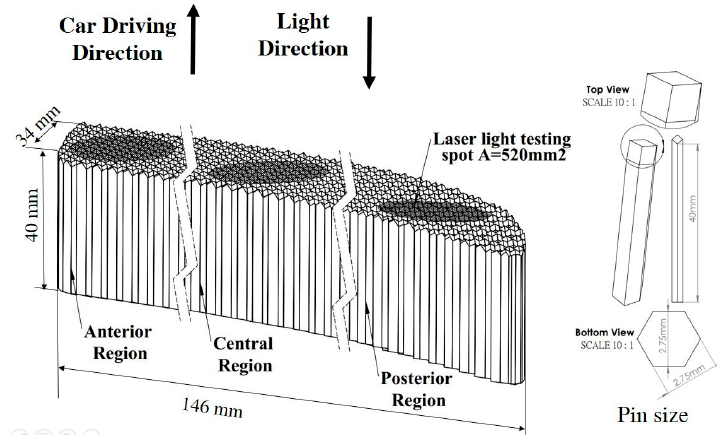
Figure 8. The test regions of CCCR; each testing area is 520 mm 2 .